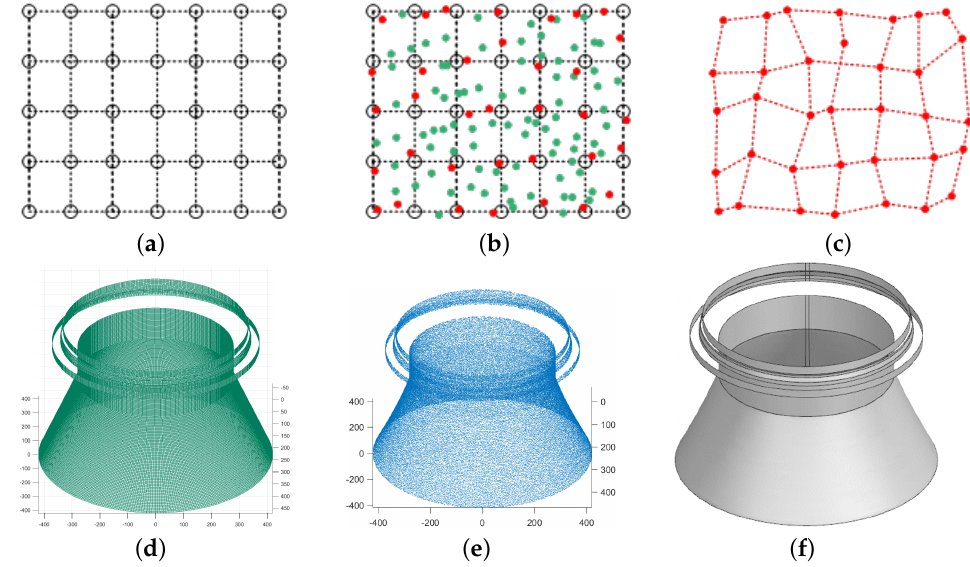
Figure 13. The process of grid point offset. ( a ) The CAD grid points with a resolution of 0.4 mr. ( b ) Nearest neighbors of the CAD grid point in the point cloud model. ( c ) The NURBS of real workpiece constructed by grid point. ( d ) All of the CAD model grid point. ( e ) The offset data points according grid point. ( f ) Modeling